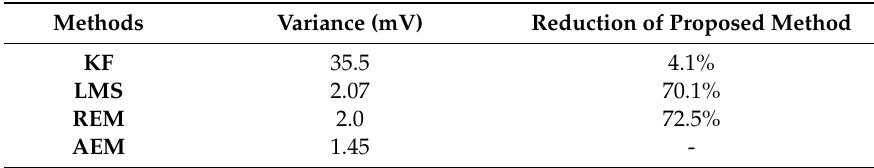
Table 5. Variance of the equivalent input under dynamic condition with multi